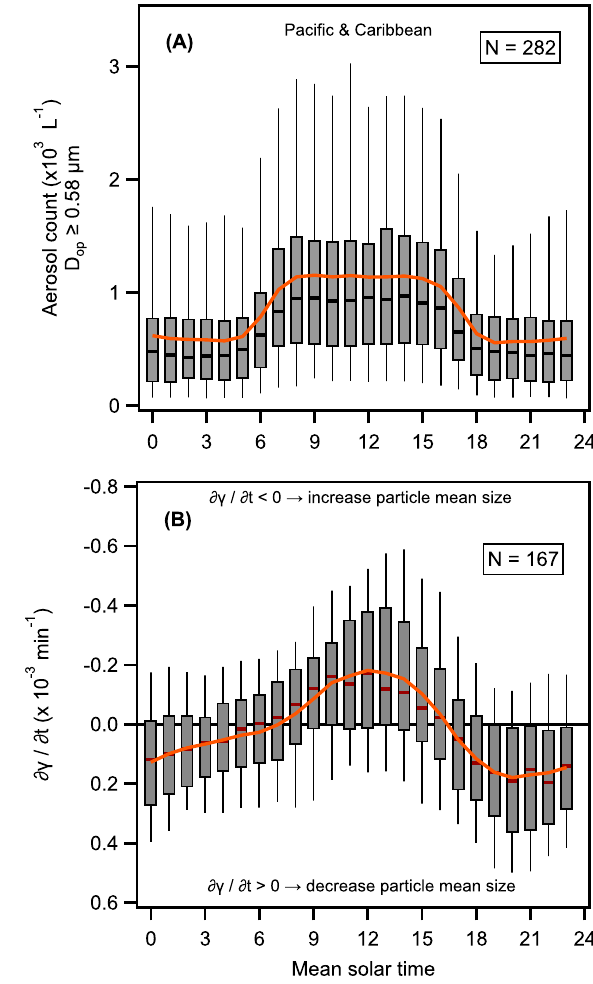
Fig. 5 Dependence of the day-to-nighttime ratio (DNR) of the sea spray aerosol number concentration with an optical diameter ( D op ) ≥ 0.58 μ m (N SSA ≥ 0.58 µ m ) on total daytime aerosol count for three different wind speed regimes. For daily mean wind speeds below 4 ms − 1 (black circles), between 4 and 8 ms − 1 (orange triangles), and above 8 ms − 1 (blue squares) for A all the data, and B a clean atmosphere (i.e., only in the Paci fi c Ocean at least 100 km away from the continents). N refers to the number of days analyzed. While there is no clear relationship between the DNR of N SSA ≥ 0.58 μ m and the wind speed, the DNR tending to one as the total aerosol count increases shows that long-range transport of aerosols can mask the diel cycle.